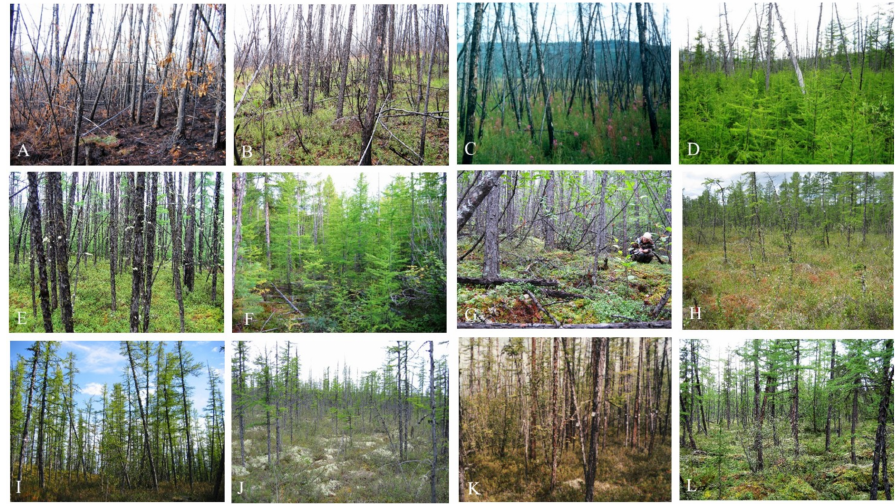
Figure 2. Study sites in Tura. ( A ), T20 in 2009 (0-year-old); ( B ), T20 in 2011 (2-year-old); ( C ), T21 in 2001 (7-year-old); ( D ), T21 in 2011 (17-year-old); ( E ), T23 in 2007 (27-year-old); ( F ), T22 in 2010 (29-year-old); ( G ), T1 in 2011 (101-year-old); ( H ), T3 in 2009 (107-year-old); ( I ), T4 in 2010 (108-year- old); ( J ), T6 in 2010 (141-year-old); ( K ), T2 in 2001 (253-year-old); ( L ), T2 in 2011 (272-year-old). The climate in the Tura area is continental (mean annual air temperature − 9.5 ◦ C) with wide temperature amplitudes and precipitation distribution. Cold winters (mean air temperature in January is − 36.7 ◦ C) and moderately warm summers (mean air temperature in July is 16.3 ◦ C) with the annual precipitation range of about 250–548 mm are typical for the studied region. The study sites are characterized by underlying continuous